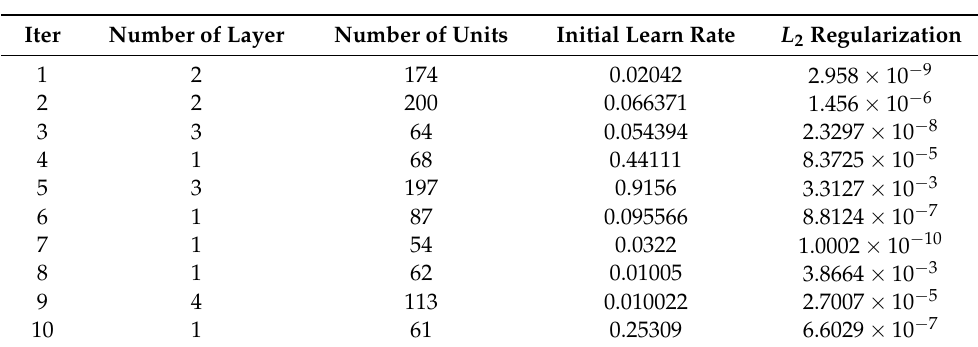
Table 4. Bayesian optimization.